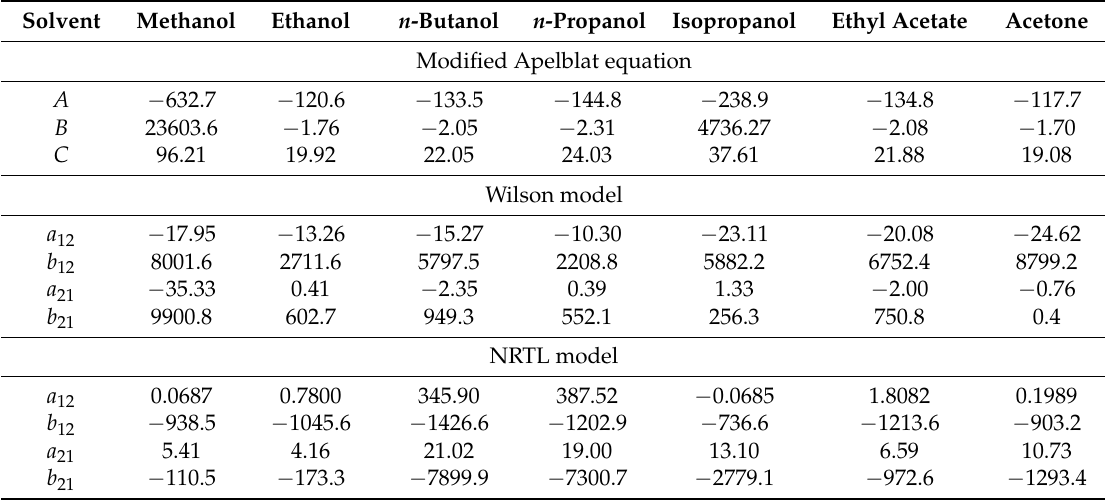
Table 3. The calculated parameters of the equations for solubilities in different solvent.